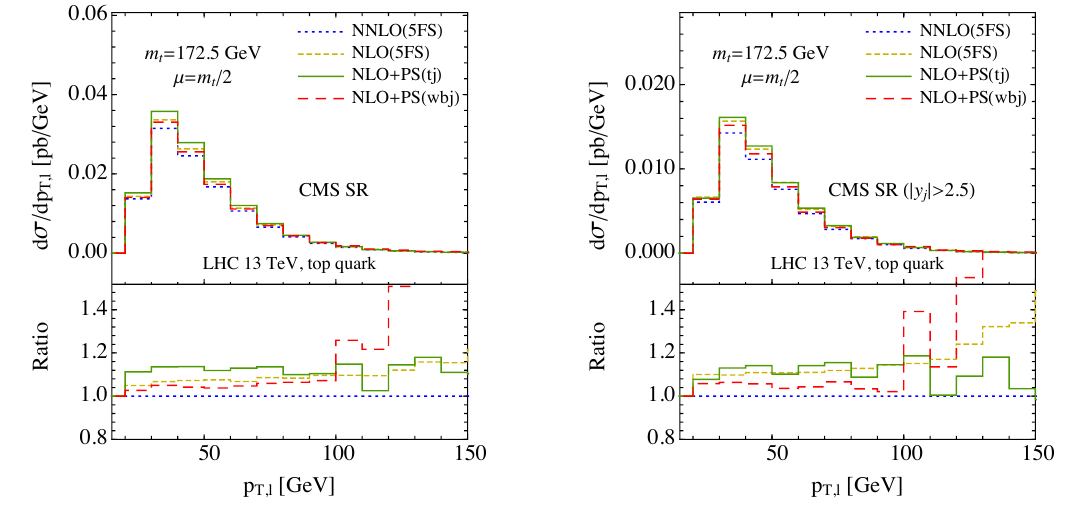
Figure 6 . Transverse momentum distribution of the charged lepton within the two fiducial regions, comparing predictions at fixed-order and those from event generators tj and Wbj (see text for details) in the 5FS for LHC 13